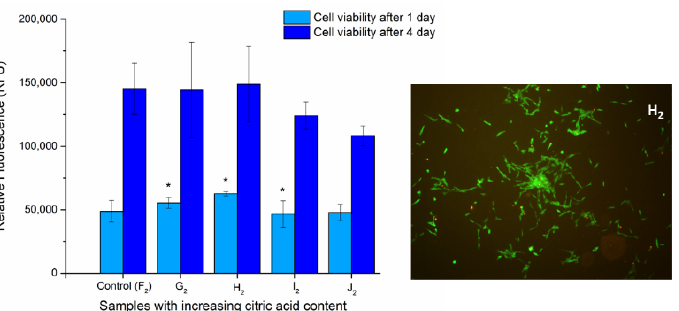
Figure 9. Cell viability assay of DPSC cells: Cells were cultured on the surface of fiber-covered glass coverslips for 1 and 4 days. After incubation, cell viability ( left ) was measured by Alamar Blue assay. Values are expressed as sample means; * means samples significant to one another, while error bars represent the standard deviation (SD) of three parallel measurements ( p < 0.05). Vitality staining of MG63 cells ( right ): The cells were seeded onto the fiber-covered coverslips and cultured for 4 days. After the incubation period, cells on the different surfaces were co-stained with fluorescein diacetate and propidium iodide.